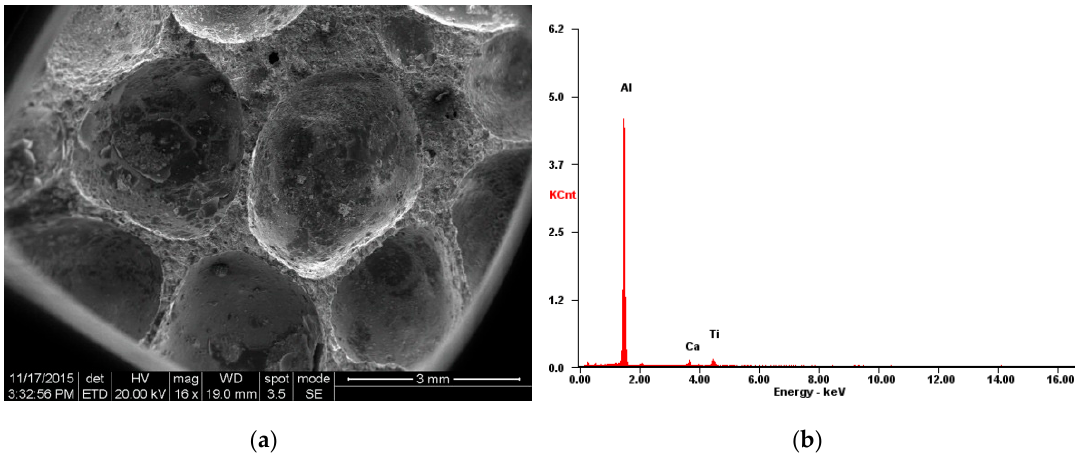
Figure 1. Electron microscope photographs of aluminum foam microstructures: ( a ) Electron microscope photograph; ( b ) energy dispersive spectrometer (EDS) result.